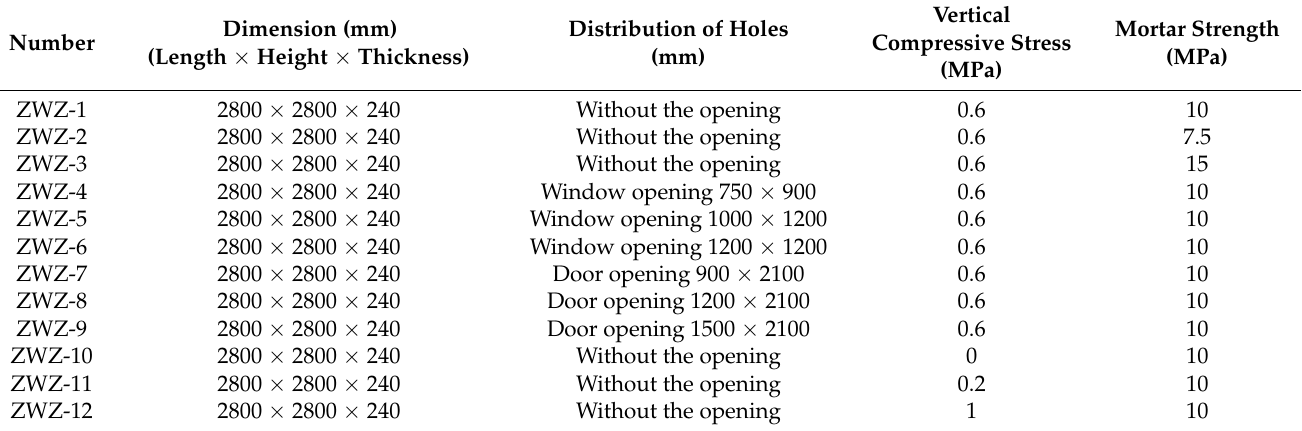
Table 6. Dimensions and parameters of walls.